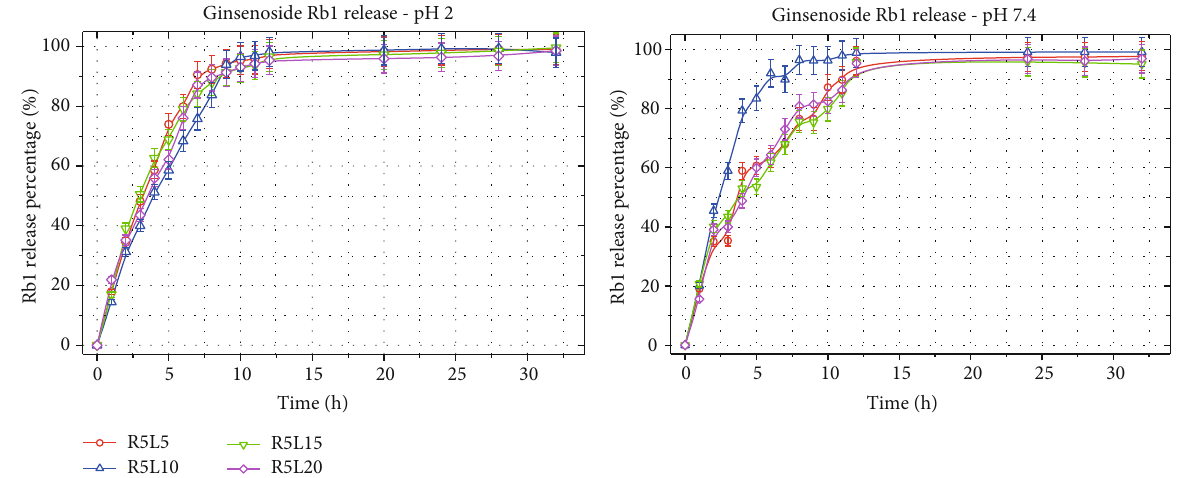
Figure 13: Percentage of ginsenoside Rb1 released from NPB-R5Ly samples in pH 2 and pH7.4